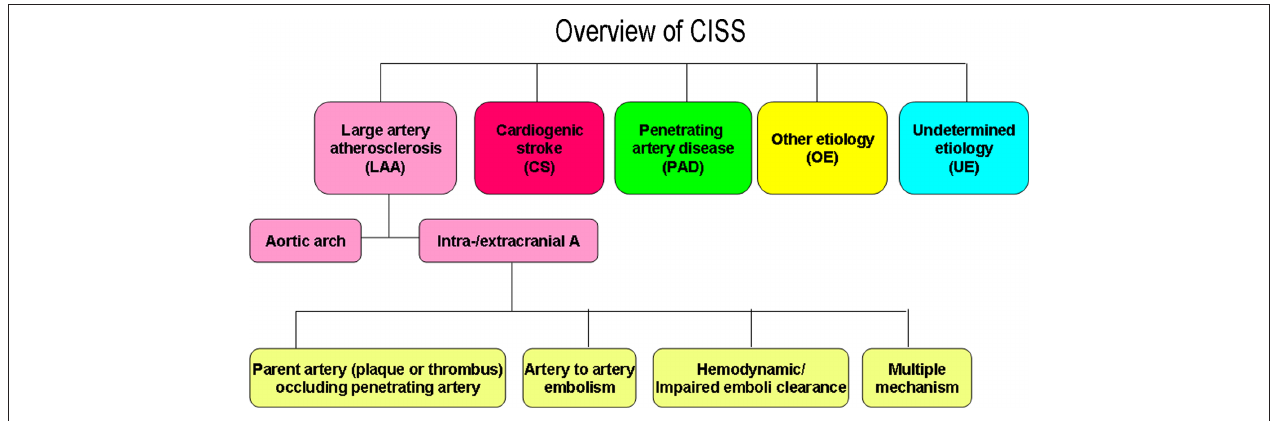
Figure 3 | Overview of